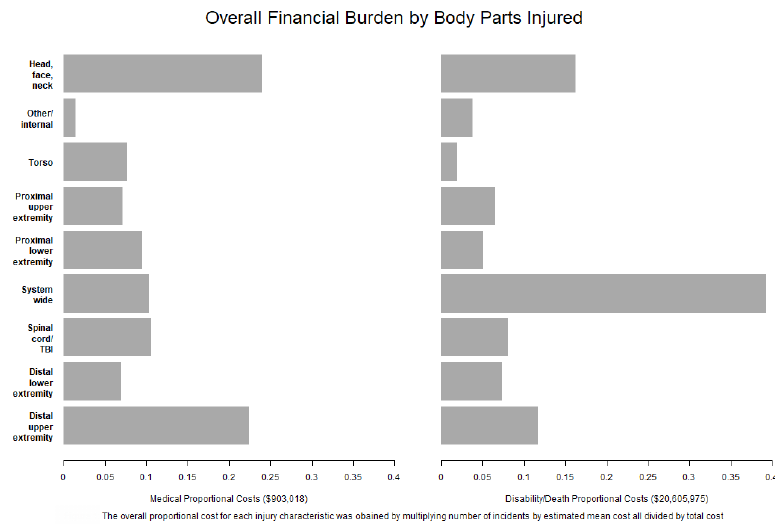
Figure 1. Overall financial burden by the body parts injured.